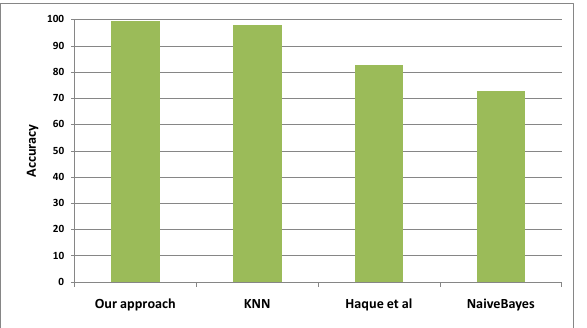
Figure 10. Detection accuracy for our approach when compared to 3 relevant alternative approaches in the literature.